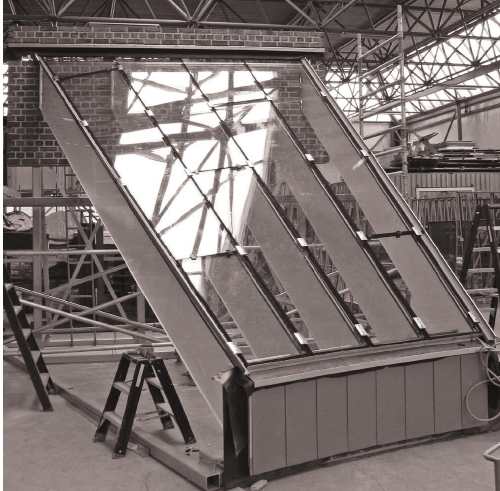
Figure 11: Full scale test assembly glass roof Victoria & Albert